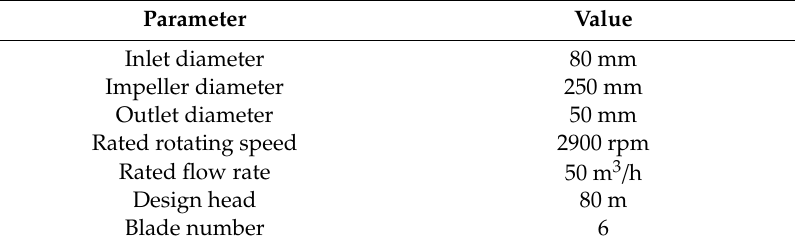
Table 1. Model parameters of the centrifugal pump.